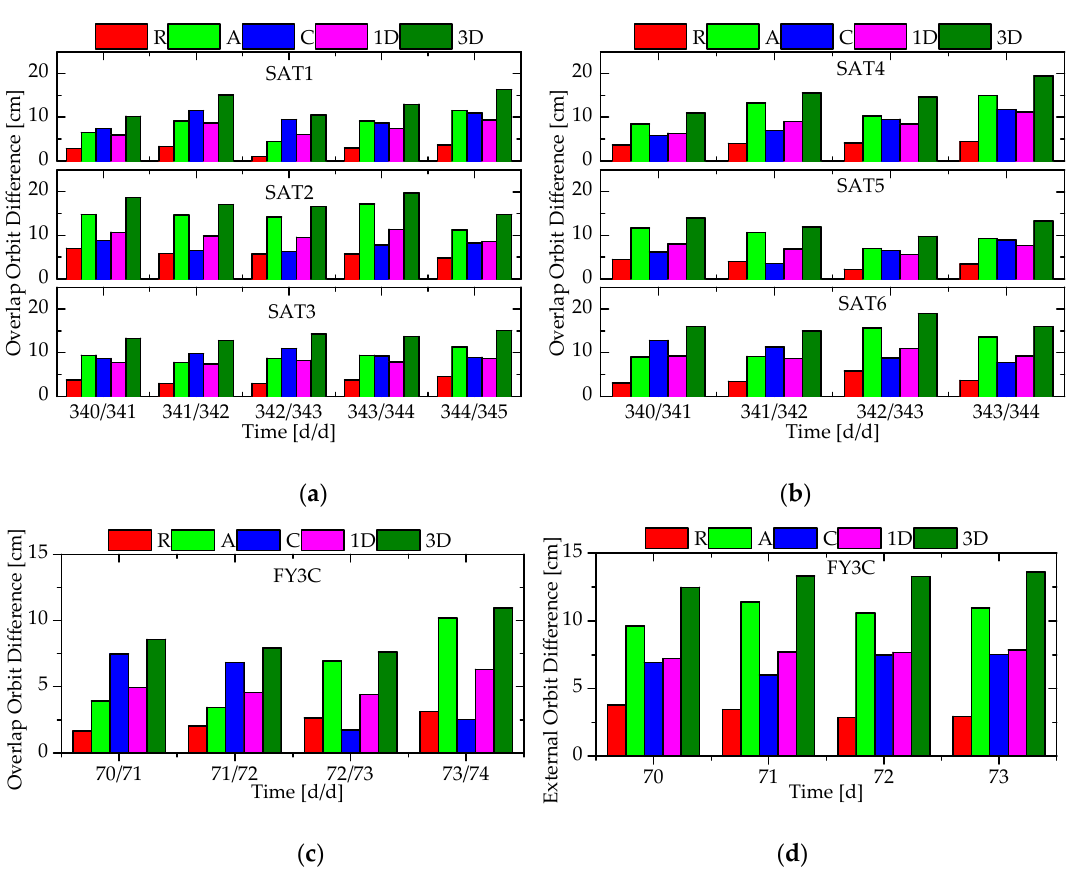
Figure 2. The post orbit accuracy assessment of the YG30/SAT1 − SAT6 and FY3C satellites using single-frequency pseudo-range measurements (C1): ( a ) The RMS statistics of the radial (R), along-track (A), cross (C), 1-dimensional (1D) and 3-dimensional (3D) overlap orbit difference of the SAT1 − SAT3 satellites; ( b ) The RMS statistics of the R/A/C/1D/3D overlap orbit difference of the SAT4 − SAT6 satellites; ( c ) The RMS statistics of the R/A/C/1D/3D overlap orbit difference of the FY3C satellite; ( d ) The RMS statistics of the R/A/C/1D/3D orbit differences of the FY3C satellite from external precise orbit products.